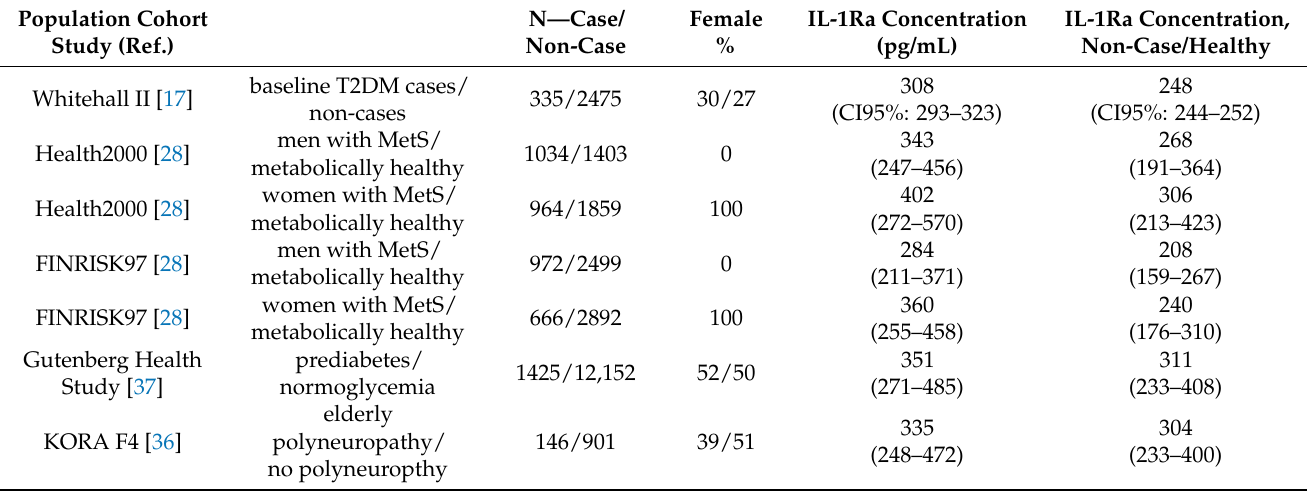
Table 1. Interleukin-1 receptor antagonist (IL-1Ra) levels in studies of population-derived cohorts. Population Cohort Study